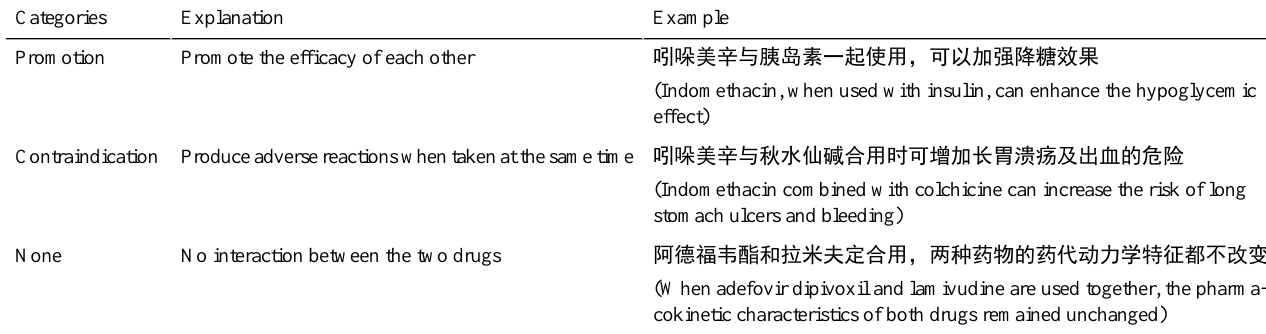
Table 4. Categories of drug-drug interaction